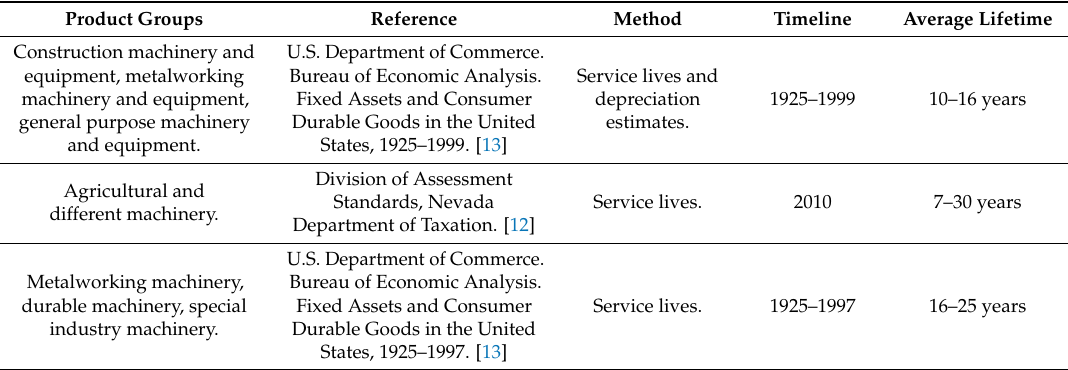
Table A2. Average lifetime of industrial-goods products and applications in the United